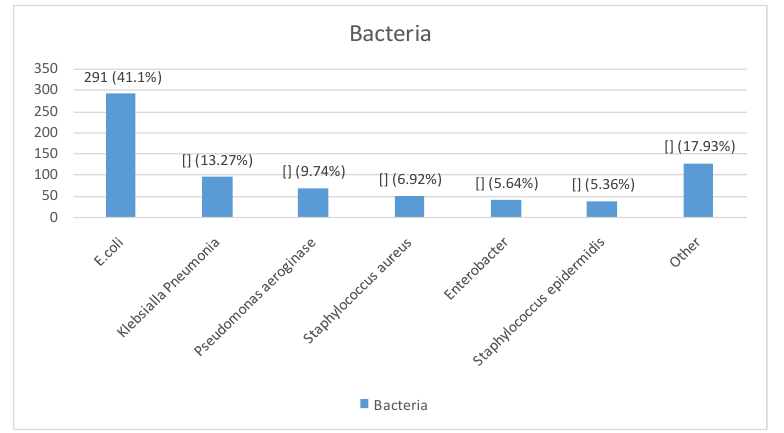
Figure 1. The frequency of urinary tract pathogenic bacteria isolated from positive urine culture